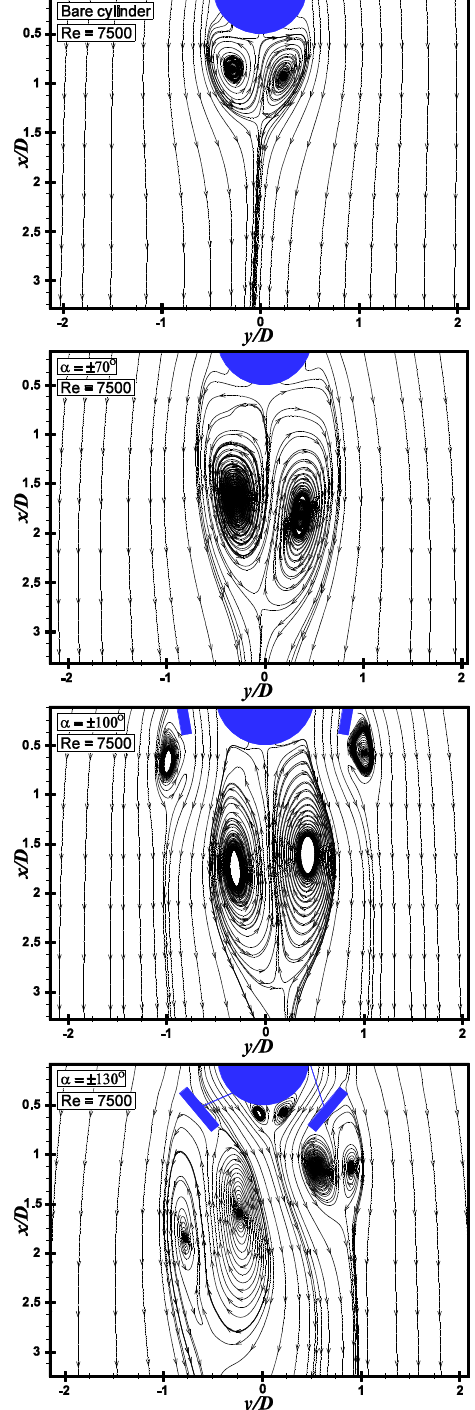
Fig. 4. Patterns of time-averaged streamline topology in the near-wake of the cylinder with and without the guiding